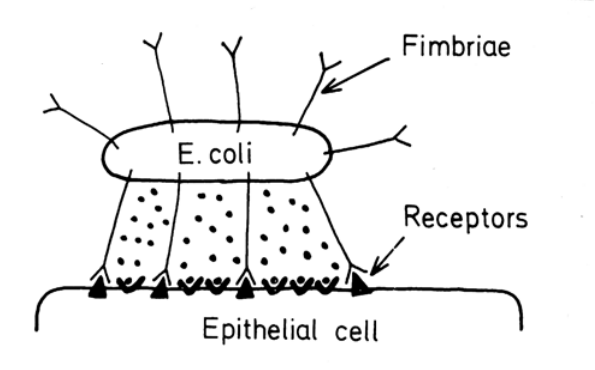
FIGURE 1. Bacterial Adhesins on pili (fimbrae) mediate attachment to specific epithelial cell receptors. (Courtesy of Cambell's Urology 7th edition, with the permission of W.B.